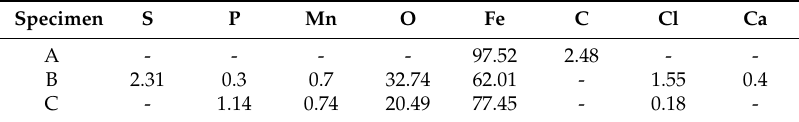
Table 4. Chemical composition measured by Energy Dispersive Spectrometer EDX